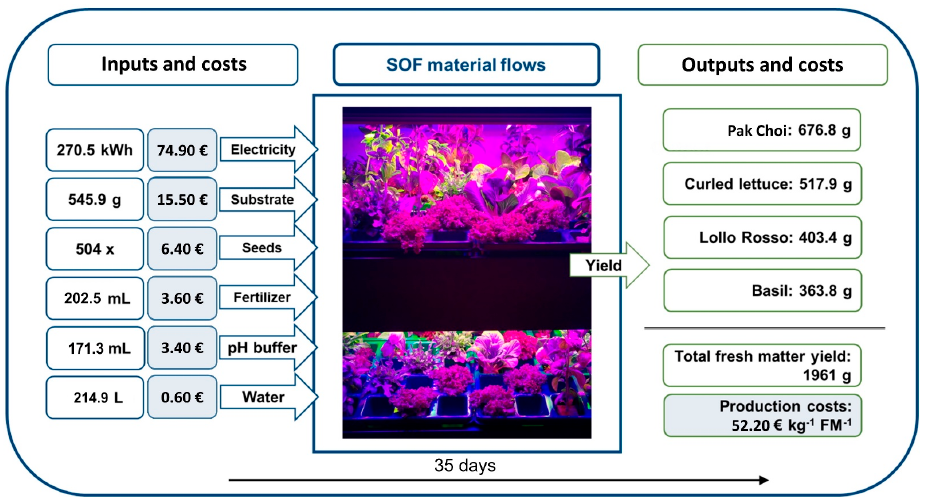
Figure 6. Overview of the material flow and production cost assessment, summarizing all inputs on the left side and all outputs on the right side (extrapolated values) (Photo: Winkler 2020). kler 2020).